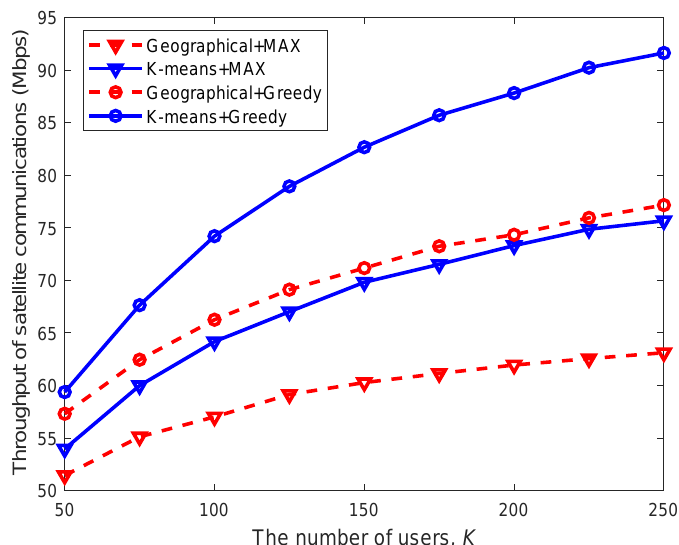
Figure 4. Satellite throughput versus the number of users with different schemes (under the full frequency reuse (FFR) pattern without cognitive radio (CR), N t = 128, N g = 10, and β =